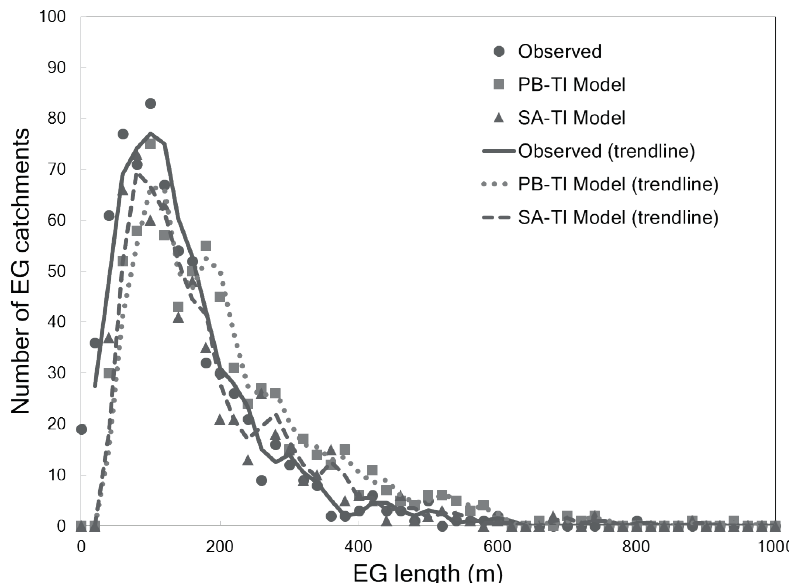
Fig. 2 Number of EG catchments for each 20 m range of EG length for observed EGs, PB-TI and SA- TI